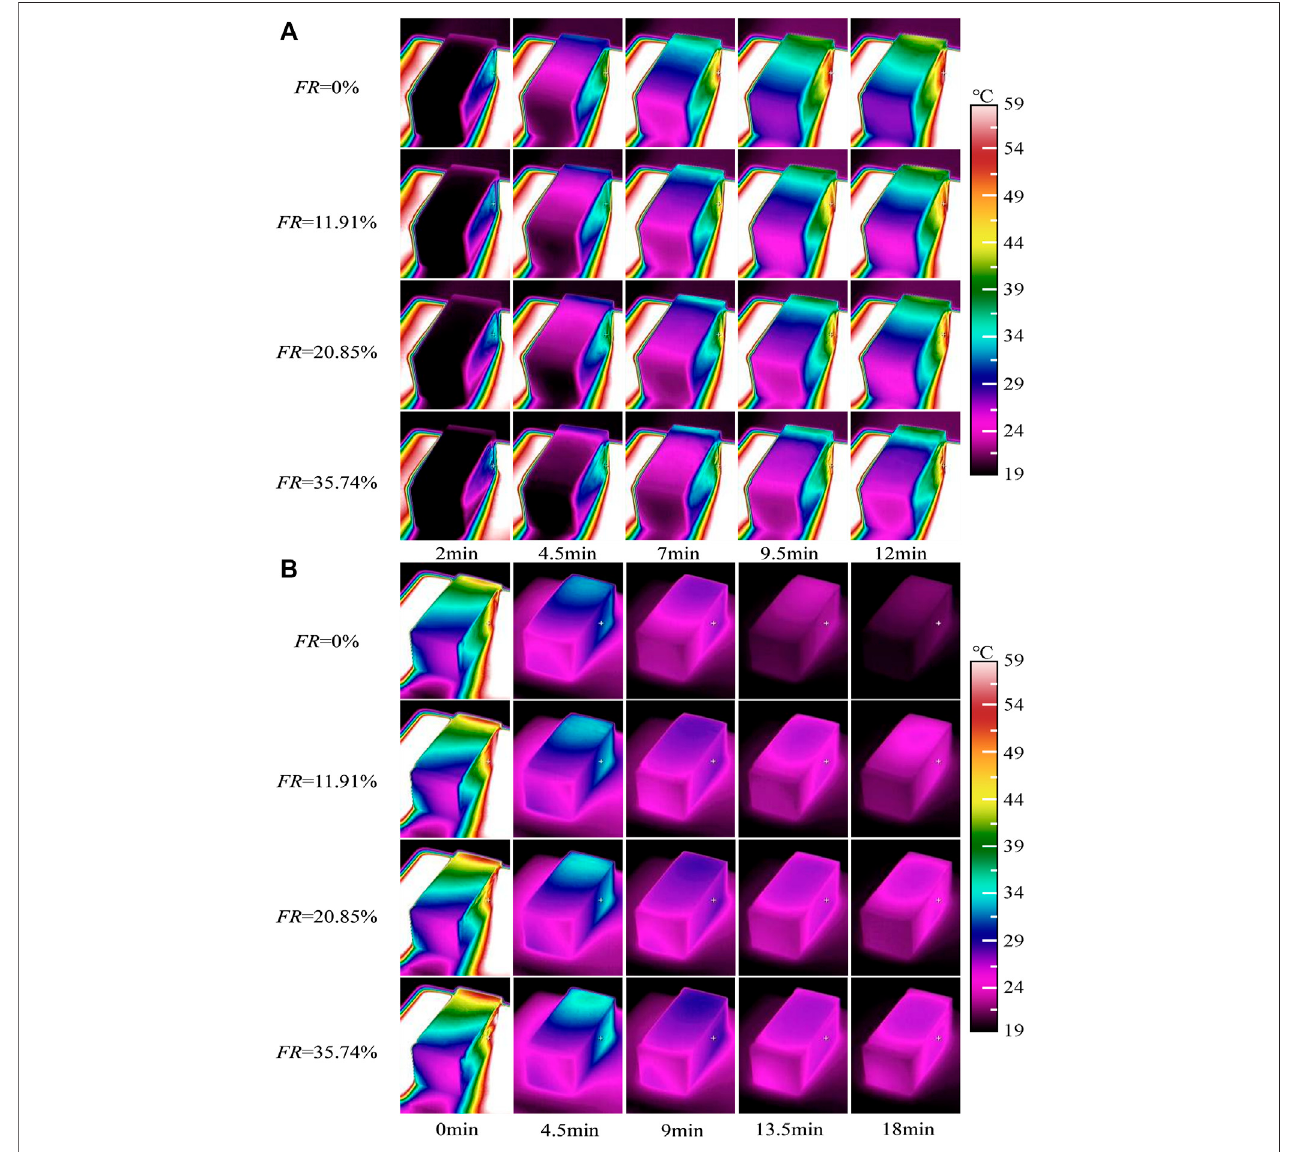
FIGURE 3 | Surface temperature distribution of model house with different FRs : (A) heating stage; (B) cooling stage.